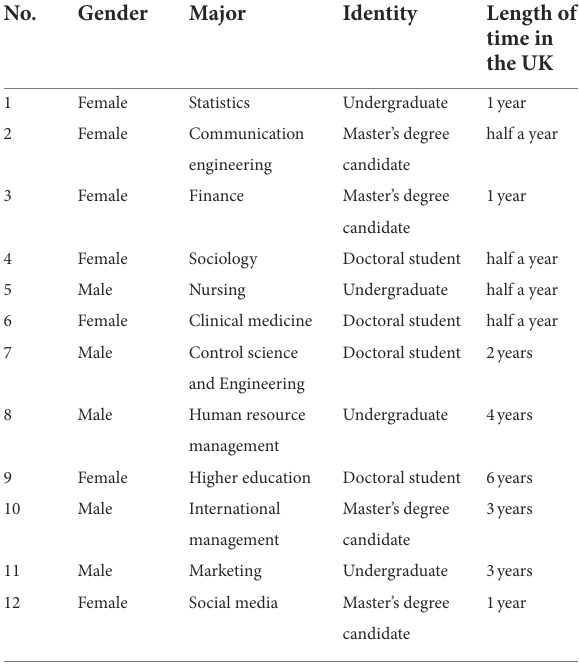
TABLE 1 Basic information of interviewed international